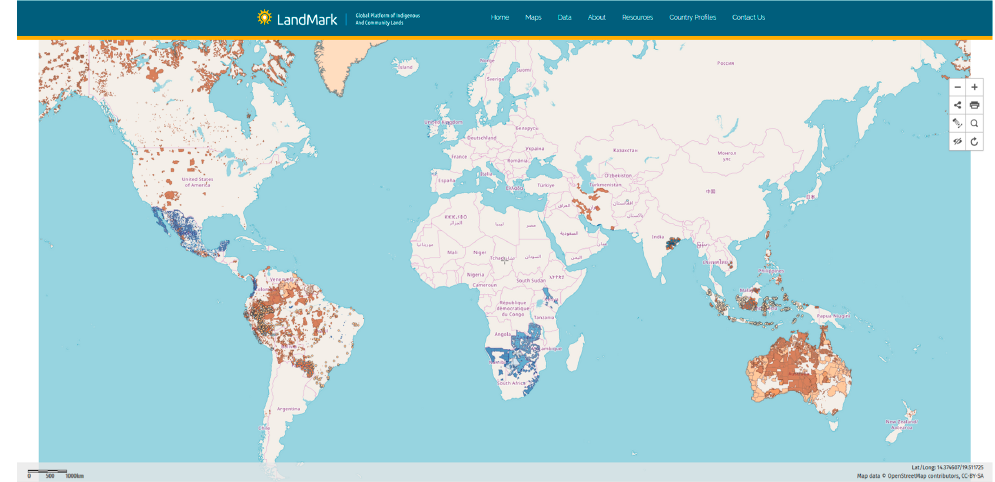
Figure 2. Partial Progress in Mapping and Recognizing Community and Indigenous Peoples Lands (2017). Note: Brown refers to Indigenous Peoples lands. Blue refers to lands of other communities. Dark brown and dark blue means these lands are registered or otherwise legally acknowledged. Light brown and light blue mean these mapped lands are not yet formalized, on a case-by-case basis. Blank means no data; millions of hectares of unidentified community lands exist in many countries, and where no mapping has yet been conducted. Source: Screenshot from the publicly—available site on community and Indigenous Peoples land: www.landmarkmap.org.